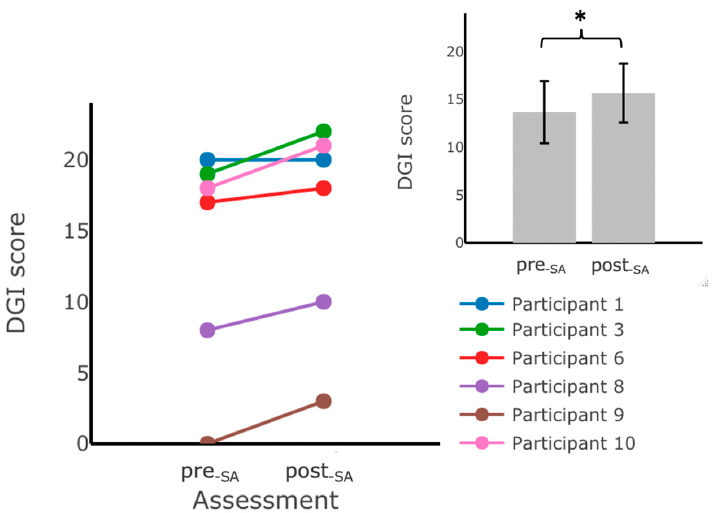
Figure 6. DGI scores measured during assessments performed in the laboratory before ( pre − SA ) and after training at home without vibrotactile SA ( post − SA ). Participants scored significantly higher on the DGI assessment after training with vibrotactile SA. The main plot shows individual trends for the participants’ DGI scores, and the inset shows the average DGI scores. Error bars on the bar plot indicate standard error (SEM) values. DGI scores from Participant 2 are not included due to missing data. (*) indicates statistically significant changes ( p <